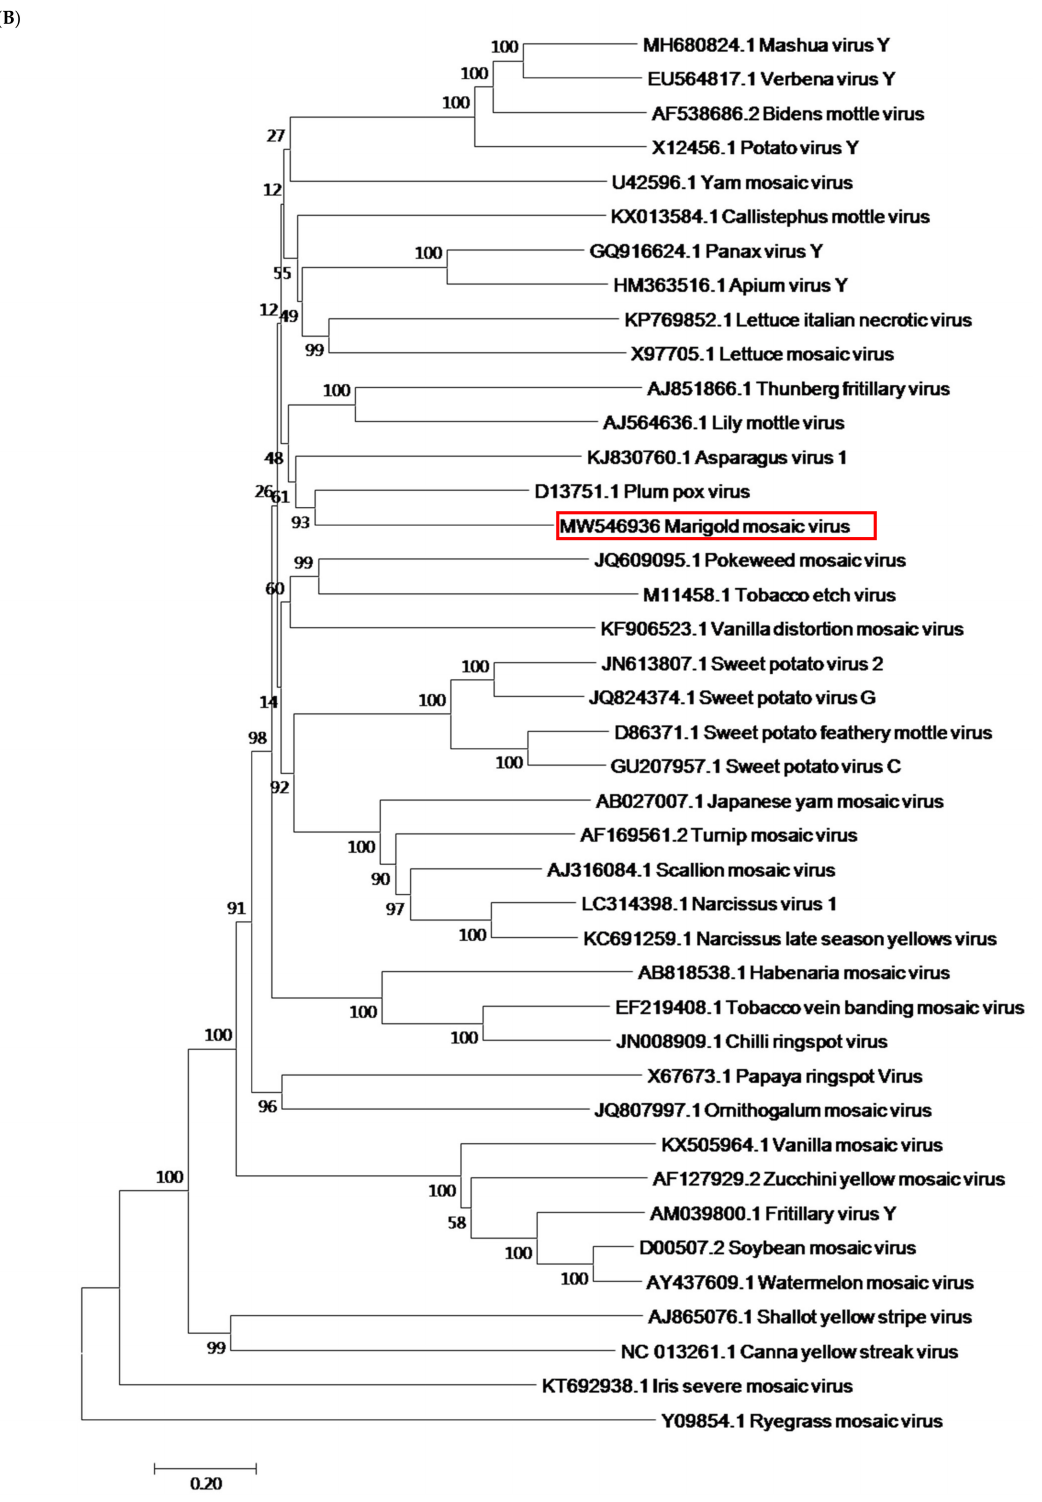
Figure 3. Genome structure of marigold mosaic virus (MMV) and its phylogenetic analysis. ( A ): Schematic representation of the genomic organization of MMV. The position of the mature protein and the proteinase cleavage sites were listed. ( B ): Neighbor-joining tree based on the polyprotein aa sequence of the members in the family Potyviridae with 1000 bootstrap replicates. Bootstrap values were given by numbers at the relevant nodes in the topology. Ryegrass mosaic virus was used as